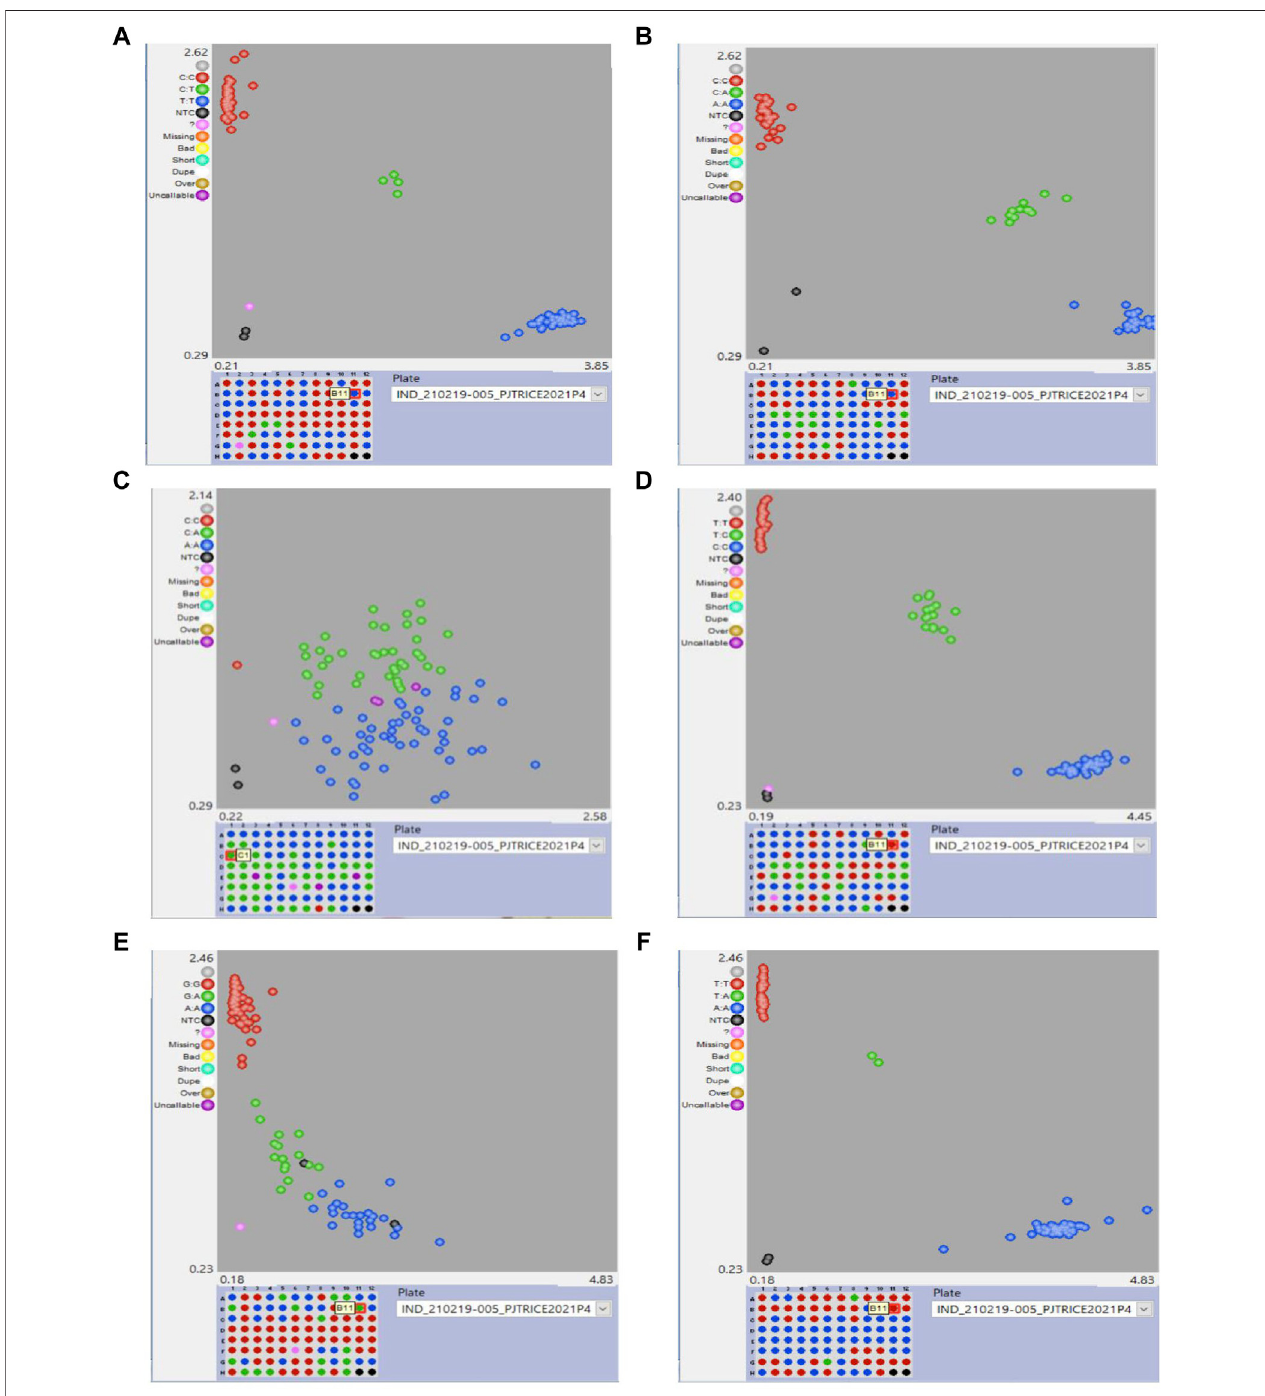
FIGURE4| ClusteringofgenotypesfortheSNPs (A) snpOS00922, (B) snpOS00923, (C) snpOS00912 (D) snpOS00915 (E) snpOS00929and (F) snpOS00927.